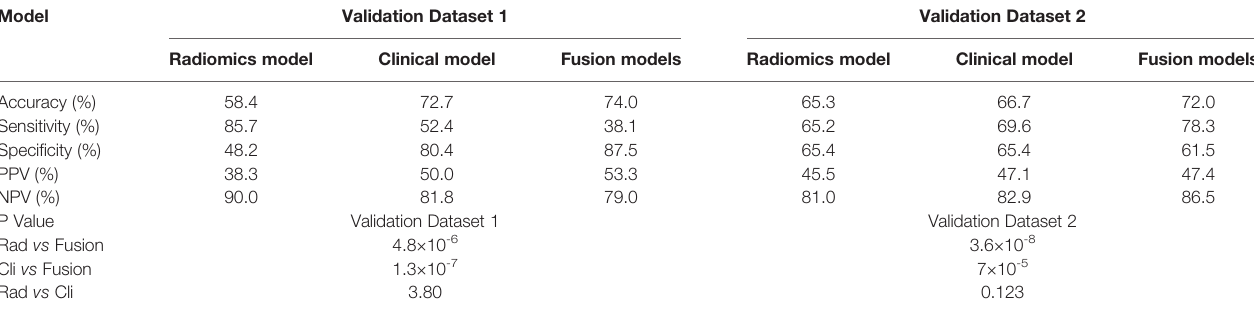
TABLE 3 | The accuracy, sensitivity, speci fi city, positive predictive value, and negative predictive value of the internal and external validation sets for each model.